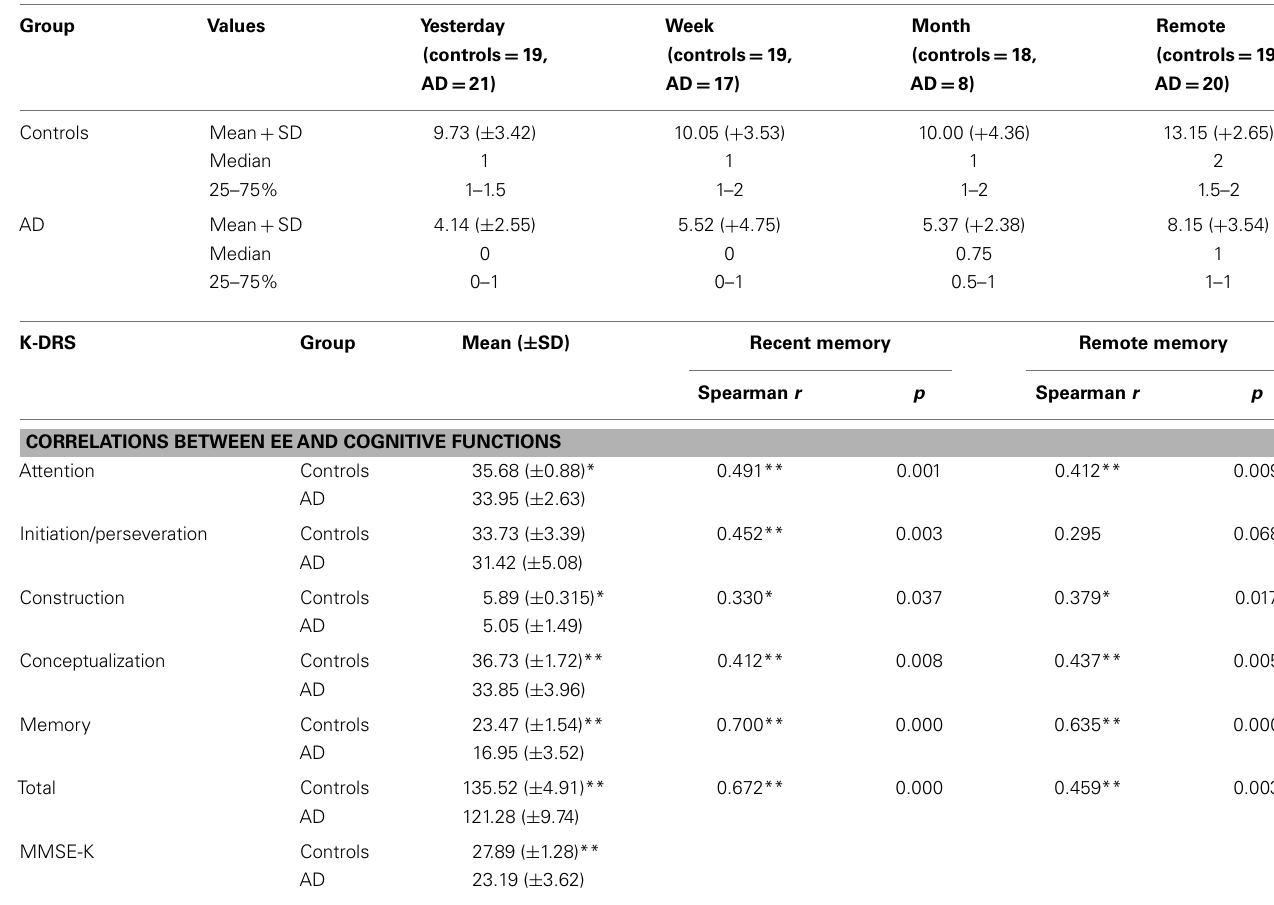
Table 2 |A comparison betweenAD groups and healthy controls, and correlations between emotional expression and cognitive functions